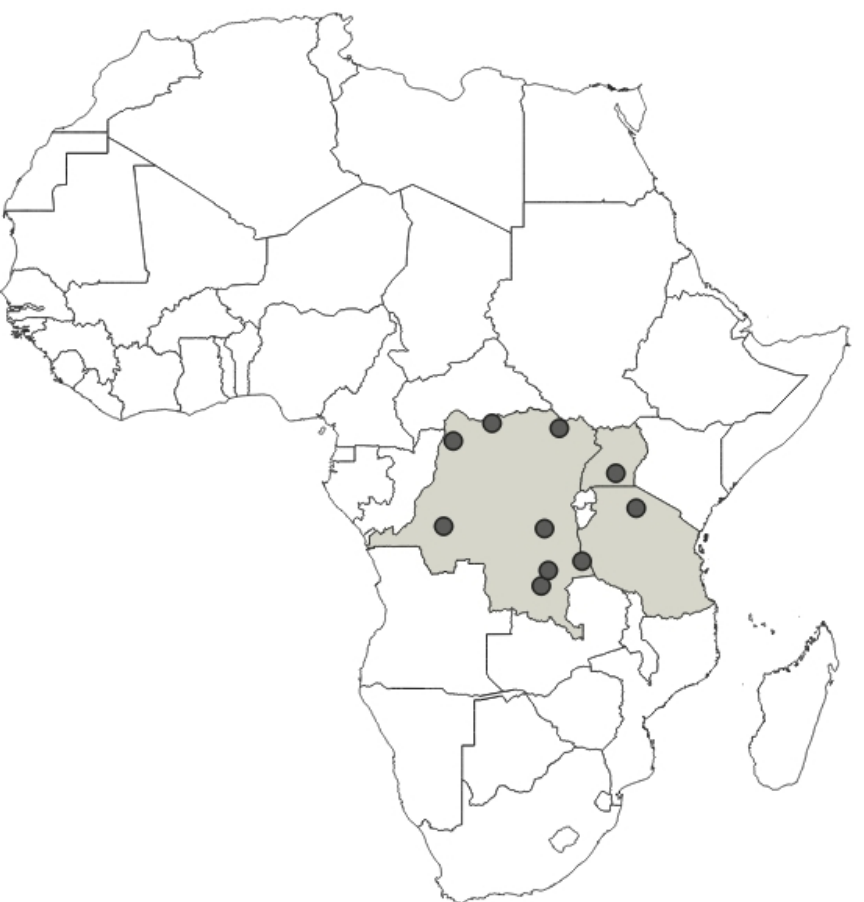
Figure 54. Known distribution of Phonoctonus picta Schouteden, 1932.